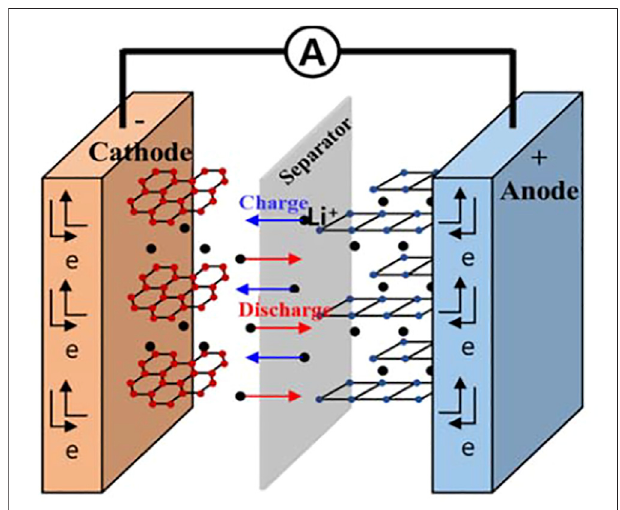
FIGURE 1 | Lithium-polymer electrochemical working